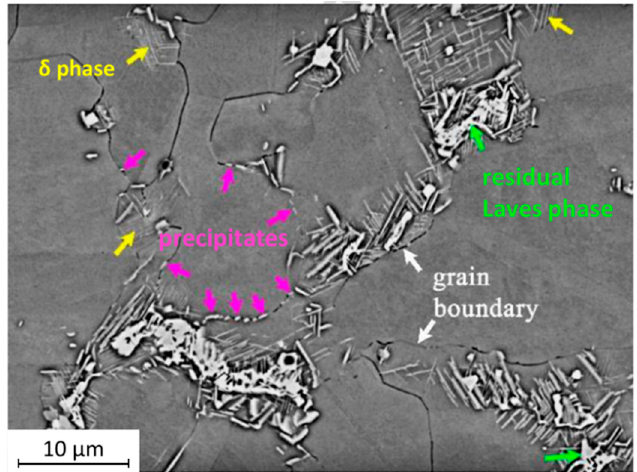
Figure 12. Precipitates found under SEM of the rolled with heat treatment sample (green: residual Laves phase, yellow: δ phase, purple: nanoscale precipitates along grain boundaries) (adapted from [63]).